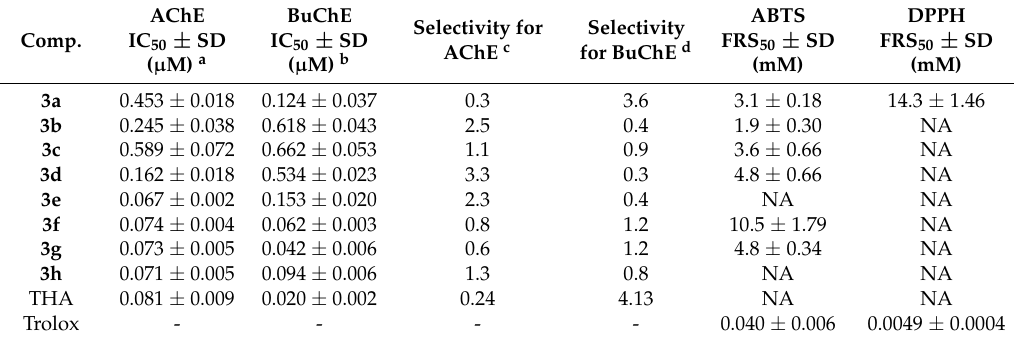
Table 1. Inhibitory effects of compounds 3a – 3h against AChE and BuChE activity and on d radical scavenging